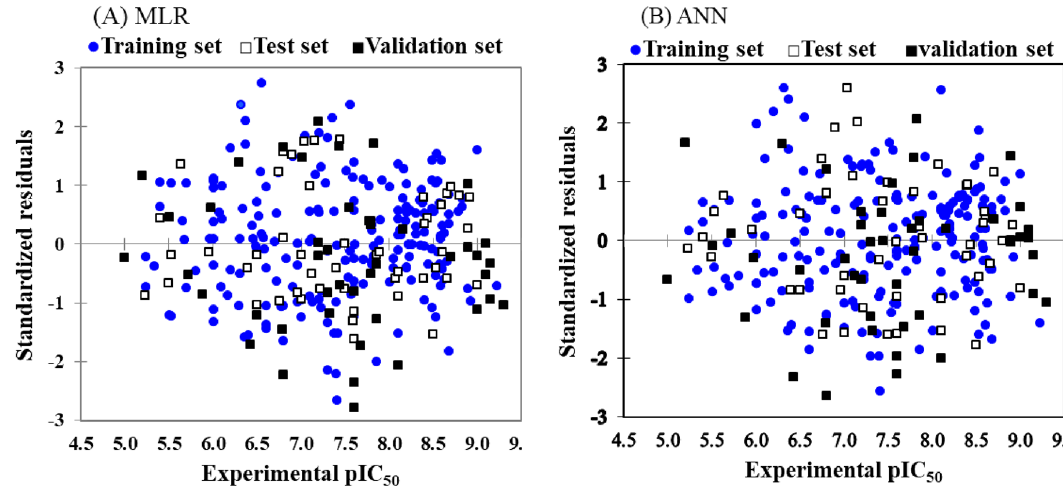
Figure 2. Dispersion plots of standardized residuals versus experimental values of the pIC 50 during the QSAR model development on PI3Kγ inhibitors.